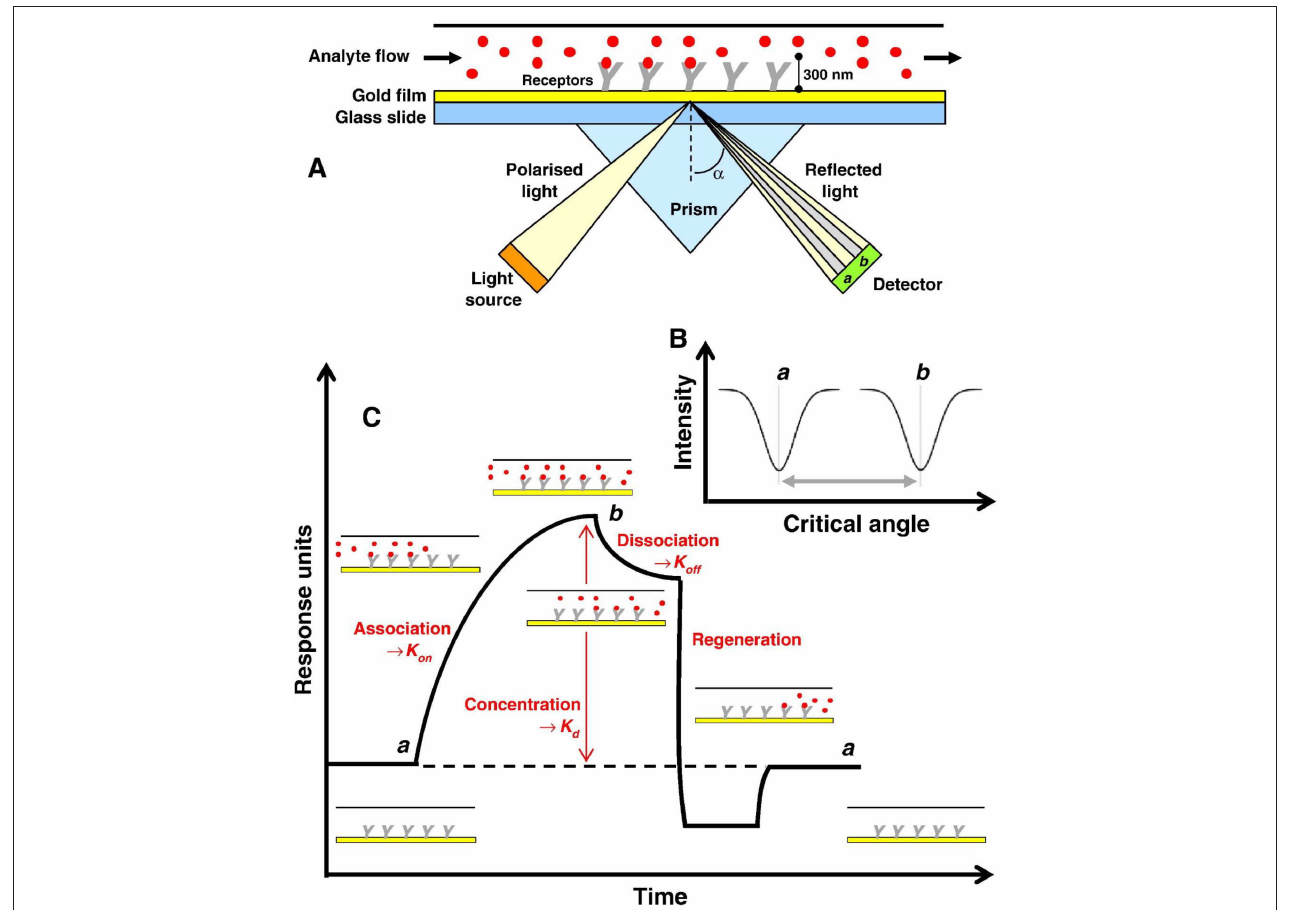
FIGURE 1 | (A) Instrument setup for an SPR experiment. (B) Change in the SPR angle of incident light from angle a to angle b on the binding of an analyte molecule to a bioreceptor molecule. (C) Response of the SPR experiment in the form of a sensogram. Figures (A–C) were reproduced from Patching (2014) with permission from Elsevier. Copyright 2014,